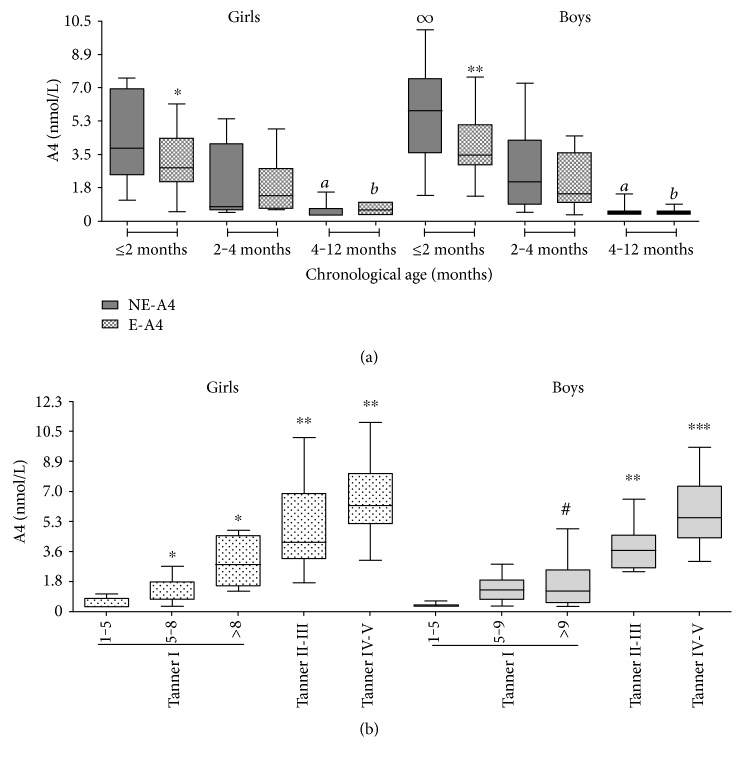
(a) Androstenedione concentration in nonextracted sera (NE-A4, grey box) and after organic solvent extraction (E-A4, dotted box) in girls and boys within the first year of postnatal life. The line denotes the median and the whiskers denote the 2.5 and 97.5 percentiles. ∗p < 0.05 and ∗∗p < 0.001 versus NE-A4 concentration in age-matched girls and boys, respectively; ∞p < 0.05 versus NE-A4 for girls ≤ 2 months; ap < 0.01 versus NE-A4 in GI within each sex group; bp < 0.001 versus E-A4 in GI within each sex group. (b) Serum androstenedione concentration in children ≥ 1 year. The line denotes the median and the whiskers denote the 2.5 and 97.5 percentiles. ∗p < 0.05 versus 1–5 years old girls; ∗∗p < 0.01 and ∗∗∗p < 0.001 versus Tanner I within each sex group; #p < 0.01 versus girls in Tanner I > 8 years.